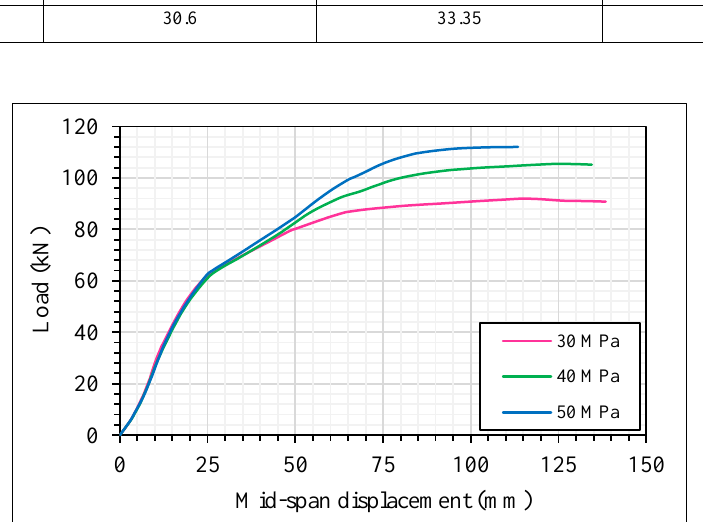
Figure 19. Effect of the compressive strength on the load-deflection